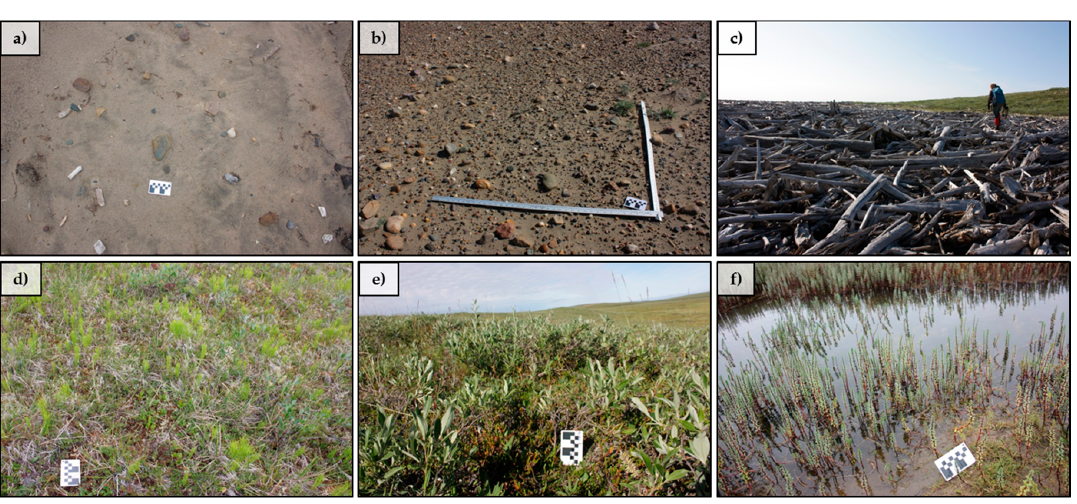
Figure 2. Example in situ imagery of select land cover classes of interest: ( a ) sand (BS); ( b ) mixed sediment (BM); ( c ) driftwood accumulation (BW); ( d ) herb dominated tundra (HT); ( e ) shrub dominated tundra (ST) and ( f ) wetland (WT). Photos were taken in 2012 on the Tuktoyaktuk Peninsula by T. Ullmann. Tobias